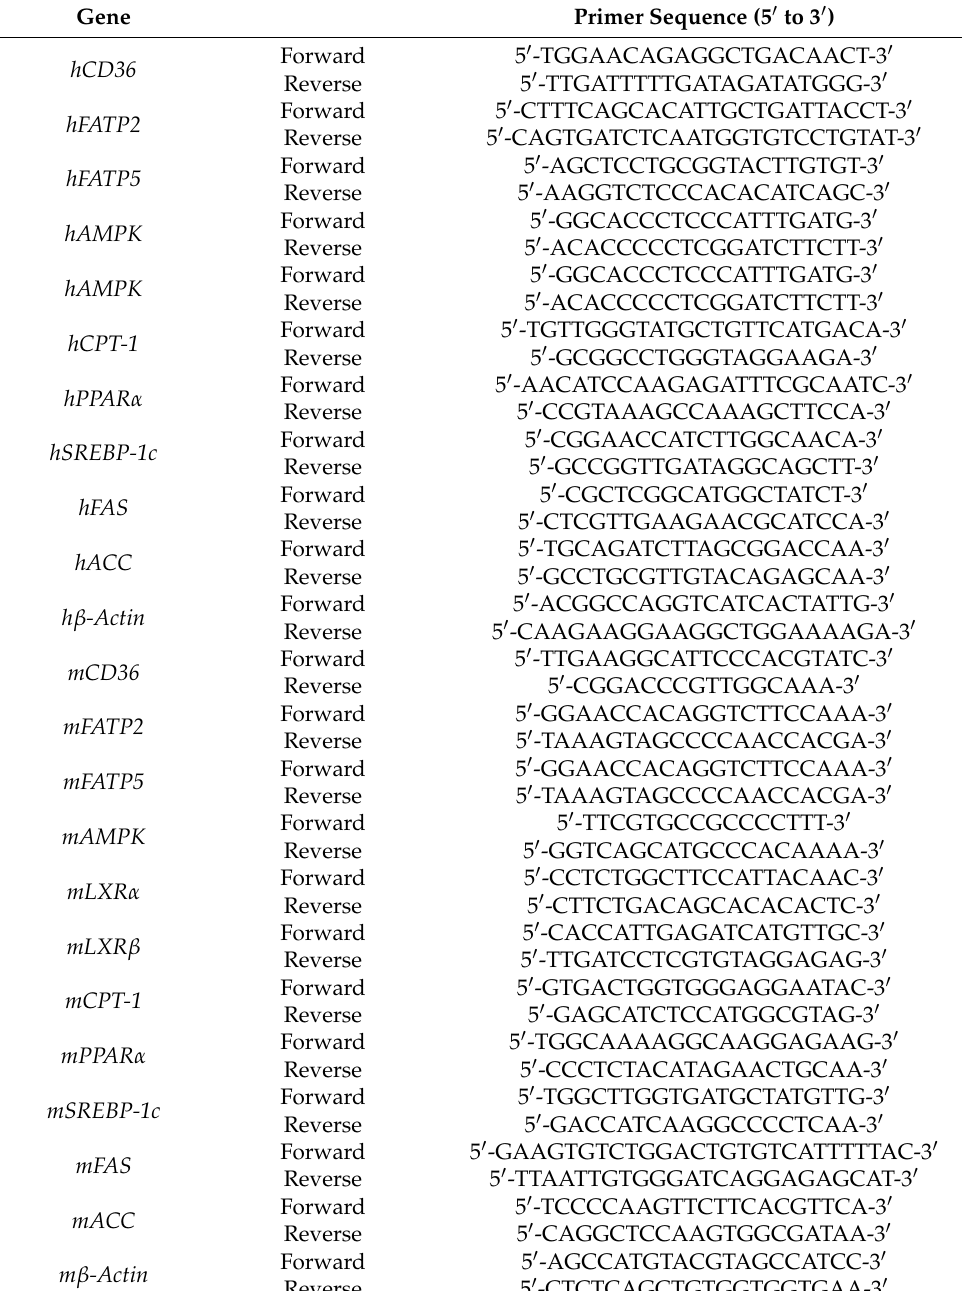
Table 1. Sequence of the primers used for real-time